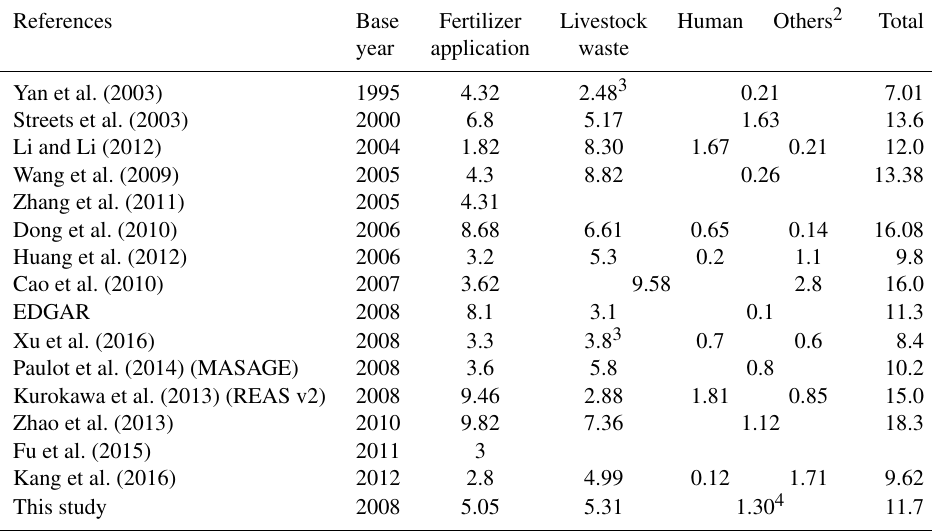
Table 1. Bottom-up estimates of ammonia anthropogenic emissions in China 1